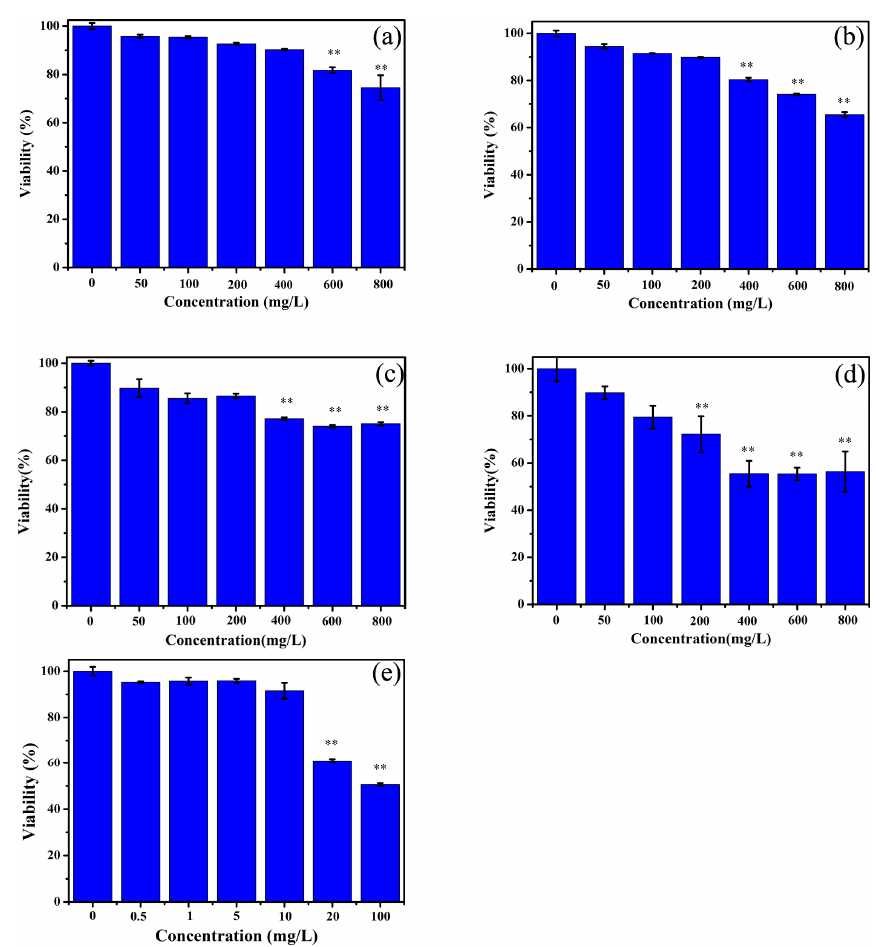
Figure 4. Cell viability assay. ( a ) Cell viability of exposing 500 nm PS-MPs (50, 100, 200, 400, 600, 800 mg / L); ( b ) Cell viability of exposing 500 nm PS-TC MPs (50, 100, 200, 400, 600, 800 mg / L); ( c ) Cell viability of exposing 60 nm PS-NPs (50, 100, 200, 400, 600, 800 mg / L); ( d ) Cell viability of exposing 60 nm PS-TC NPs (50, 100, 200, 400, 600, 800 mg / L); ( e ) Cell viability of exposing TC (0.5, 1, 5, 10,